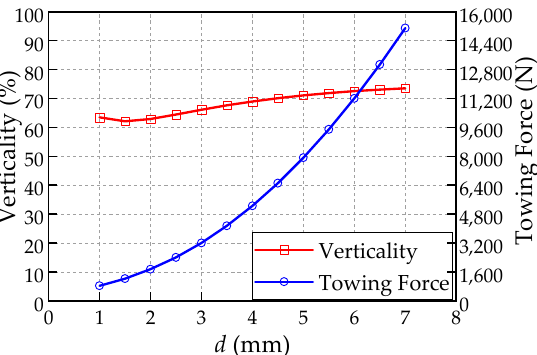
Figure 9. Verticality and towing force vs. towline diameter.